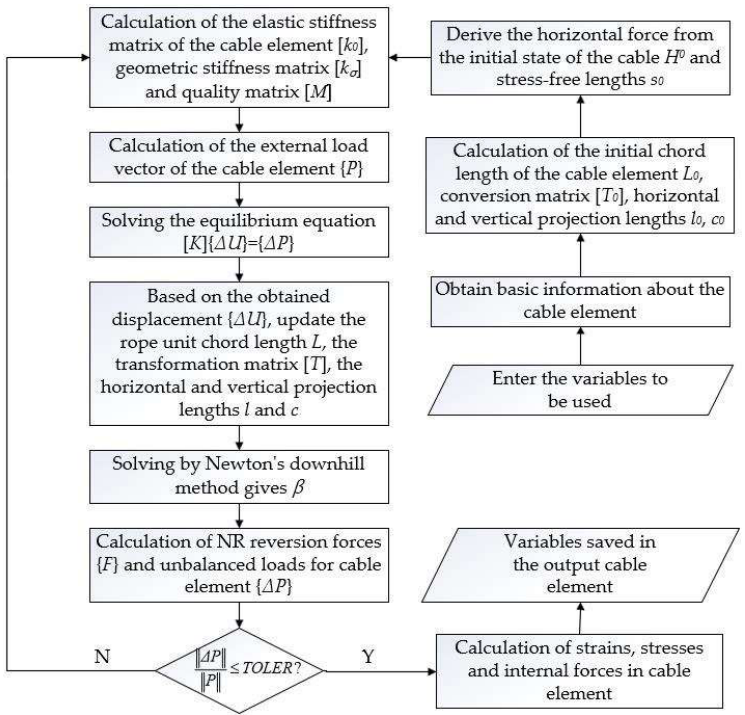
Figure 3. Calculation flow chart of subroutine UELxxx.